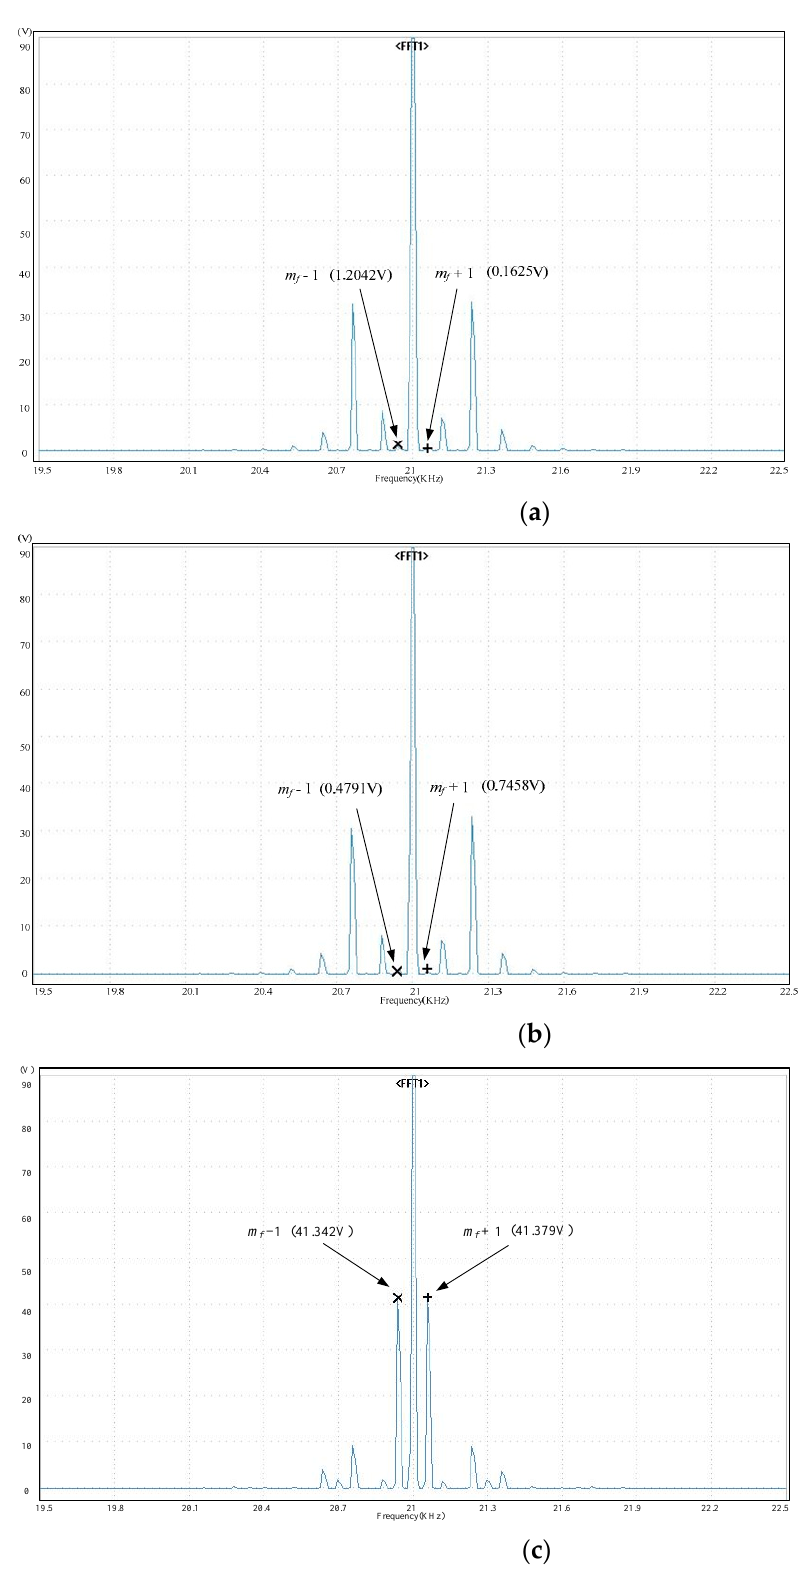
Figure 9. The frequency spectra of the various phase voltages of the inverter at a working frequency of 60 Hz with a fault in switch S c 1 + : ( a ) phase voltage v ao ; ( b ) phase voltage v bo ; ( c ) phase voltage v co .